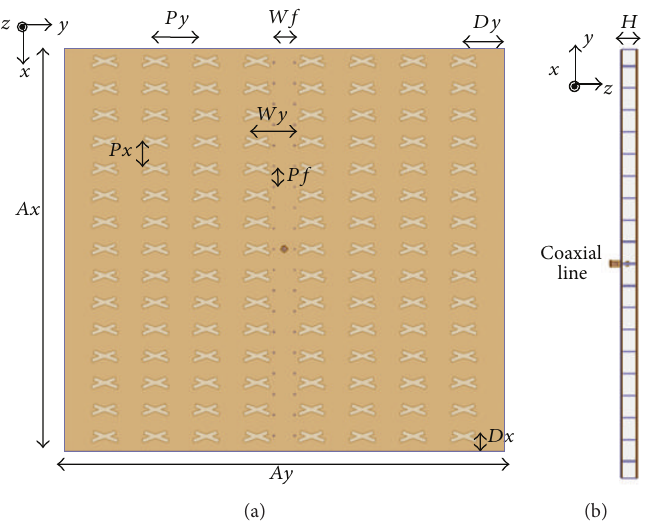
Figure 1: Slot array excited by using a Fabry-Perot cavity feeding circuit: (a) top view; (b) side